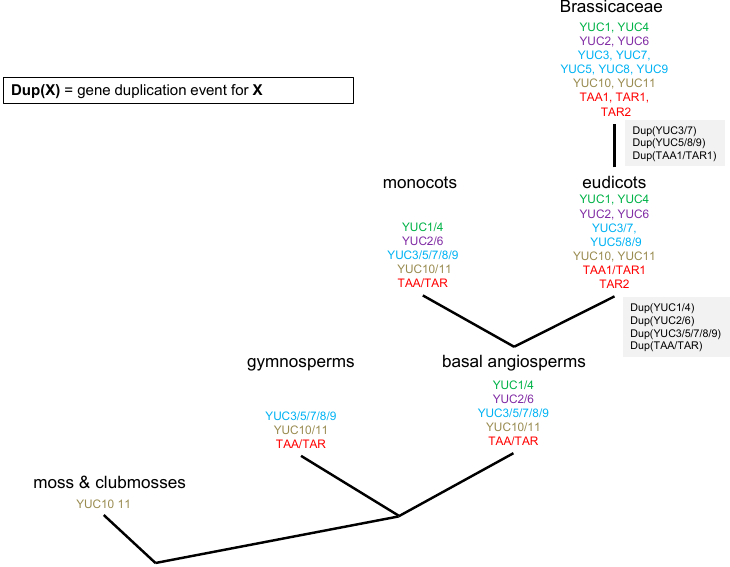
Figure 5. Evolutionary development of auxin biosynthetic enzymes in the TAA/YUC pathway. Nodes show an event of speciation, which is correlated with the appearance or the duplication of YUC or TAR / YUC genes. The name gene colors indicate the different “gene families”.